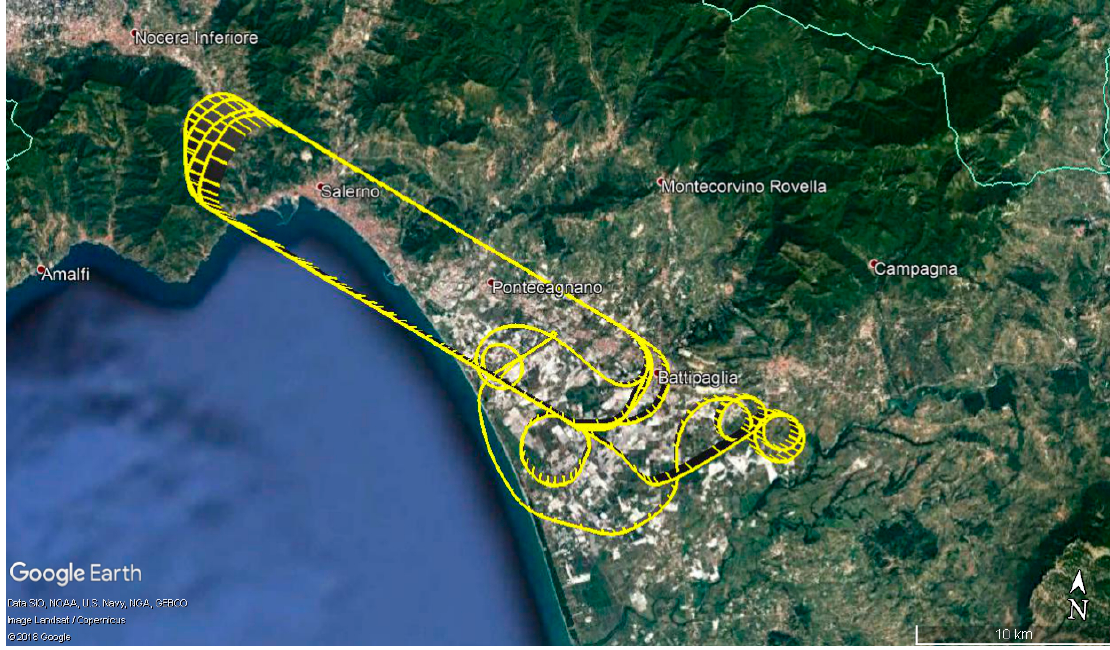
Figure 7. The flight circuits (yellow lines) flown over the Salerno area, Italy, during the AXIS acquisition campaign.